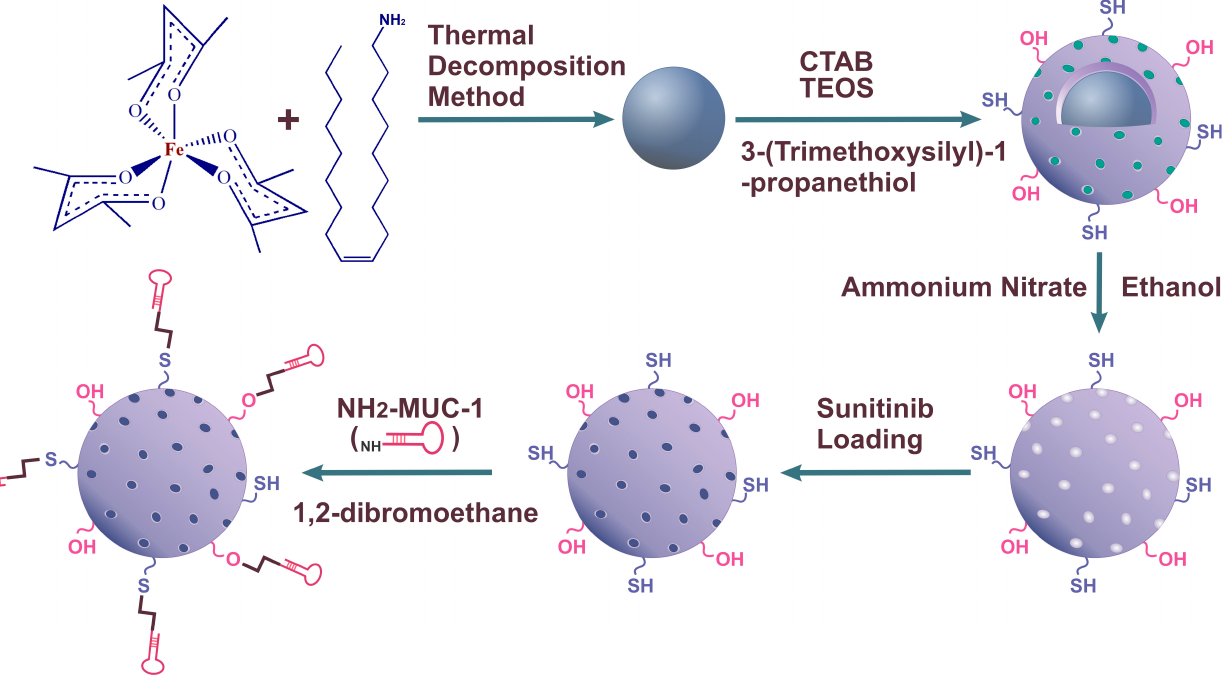
Figure 1. Schematic representation of the MMSNP-SUN-MUC-1 preparation. Magnetic cores were